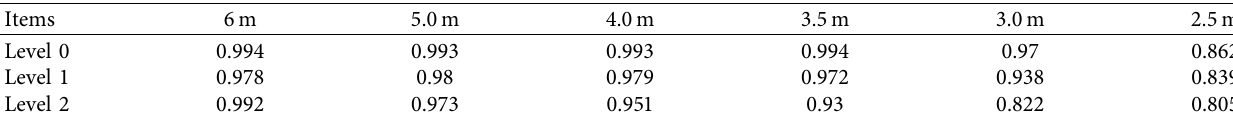
Table 13: Test results of actual arch bridge (side).